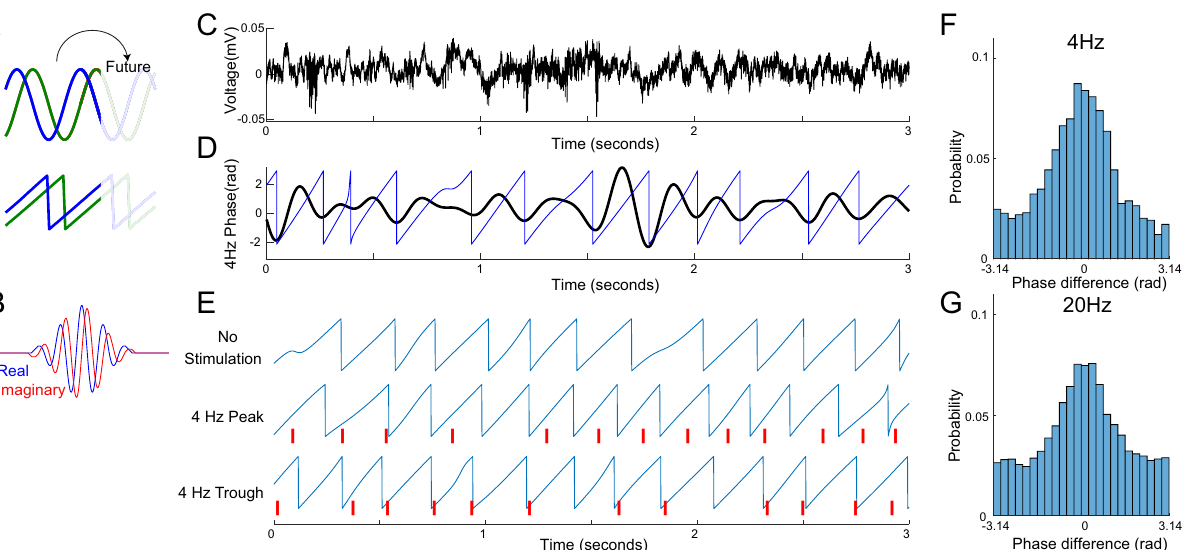
Figure 3. Phase accuracy of PABST. ( A ) To deliver closed-loop stimulation in a system with lag, we estimated oscillatory phase at future time points. ( B ) We used a complex Morlet to estimate phase and frequency. ( C ) Example of raw striatal local field potential (LFP; 3 s), ( D ) the same signal filtered at 4–8 Hz (black), and the estimated 4 Hz phase (blue). ( E ) Example trials without stimulation (top), with PABST at the peak (0 rads; middle panel) or at the trough (pi rads; bottom panel; red lines indicate PABST delivery). ( F ) Phase accuracy for all sessions from 6 mice at 4 Hz and at ( G ) 20 Hz